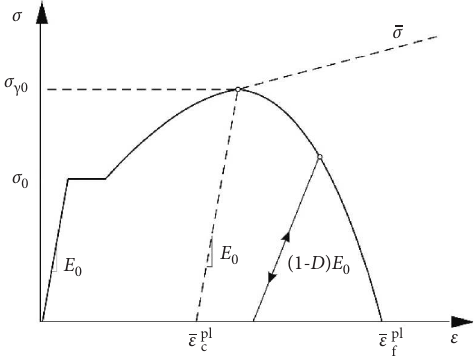
Figure 8: Stress-strain curve with progressive damage.